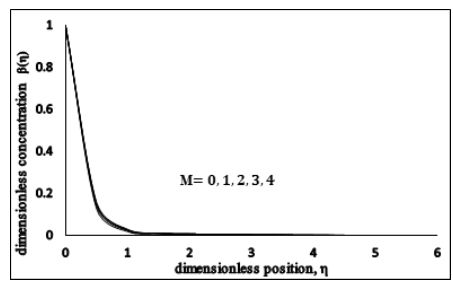
Figure 5. Dimensionless Temperature vs M .